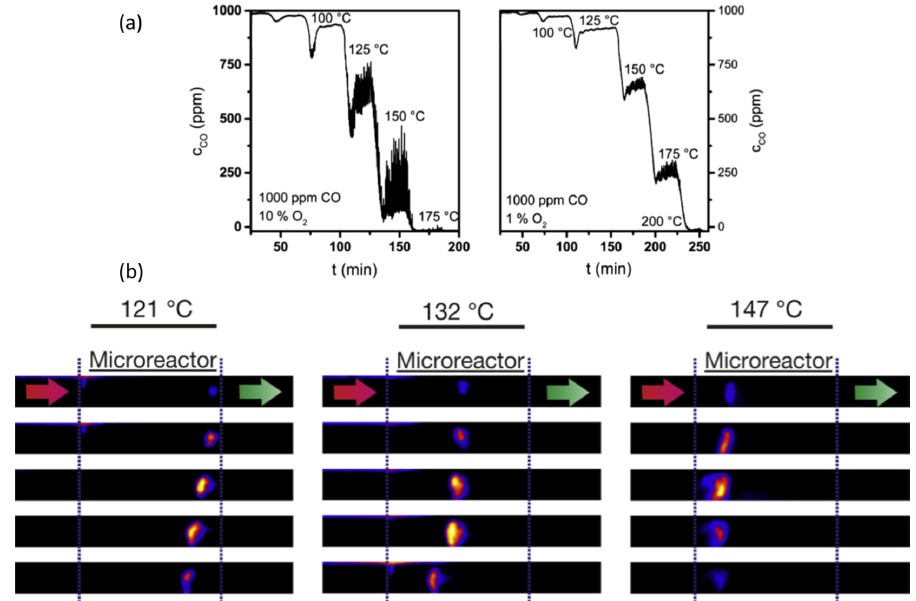
Figure 14. ( a ) CO conversion measured in a plug flow reaction using mass spectrometry as a function of temperature and for two different CO/O 2 feeds: left panel, O 2 /CO = 100:1; right panel, O 2 /CO = 10:1. ( b ) Imaging thermography showing the axial formation of reactive hot spots at different temperatures in a plug flow reactor and for O 2 /CO = 100:1 and under conditions of reaction oscillation. Reproduced